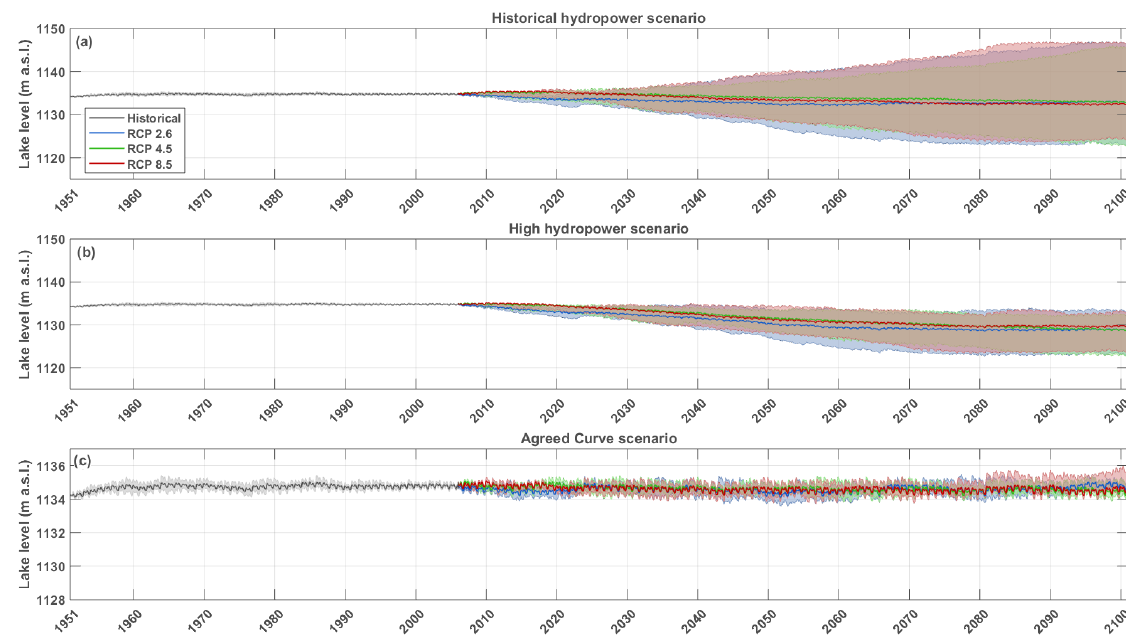
Figure E5. As in Fig. C1, but bias corrected using empirical